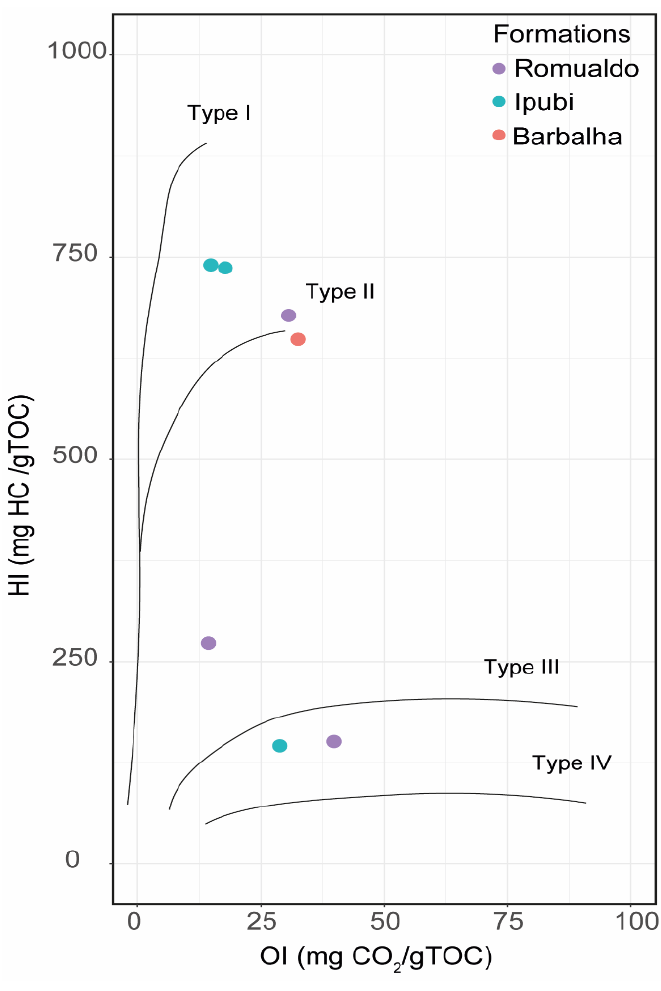
Figure 6. Crossplot of the oxygen index (OI) versus hydrogen index (HI) (Van Krevelen diagram) for classifying the kerogen types of the Santana Group. The shales of the Crato Formation do not present significant content in organic matter for this analysis (Table 1). The discriminant fields are following Espitali é et al. (1977)